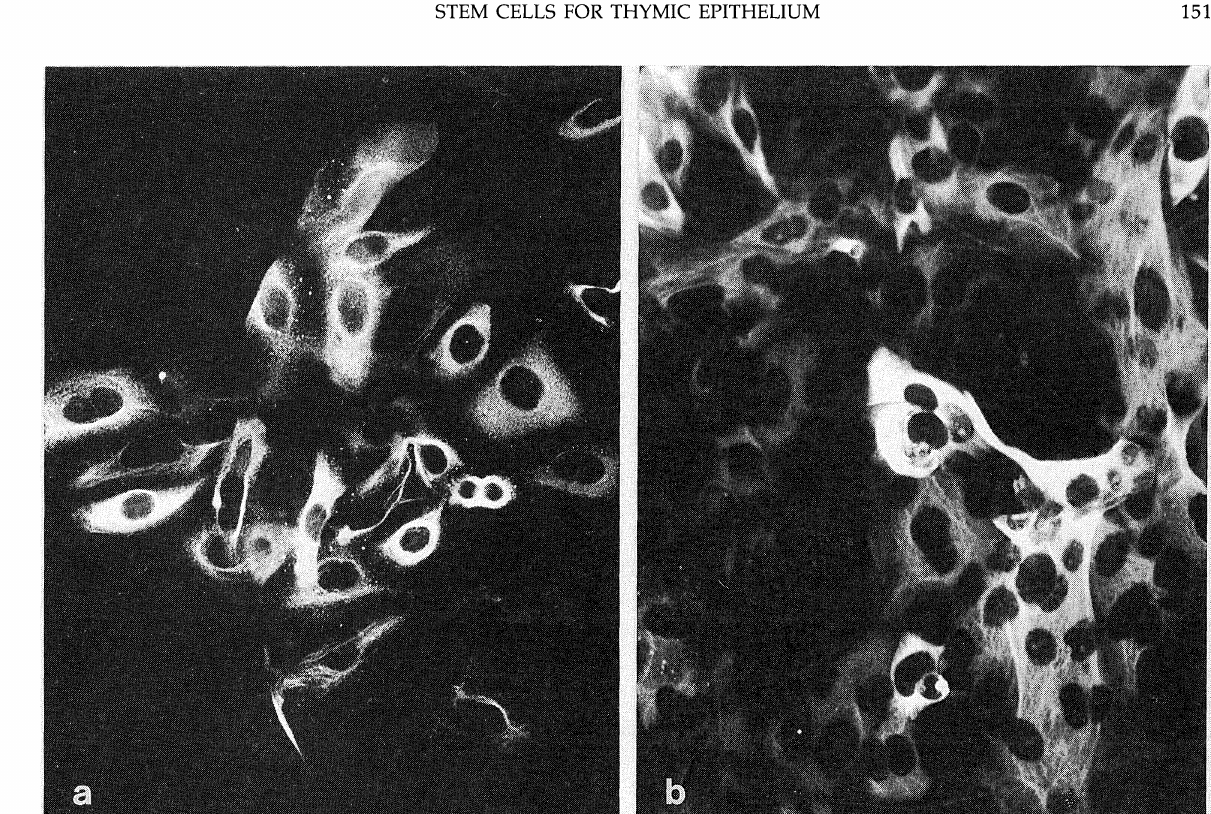
FIGURE 2. Fluorescence photomicrographs of cultured murine thymic epithelial cells. (a) Cells were labeled with ER-TR4 antibody against cortical epithelial cells. (b) Cells were labeled with ER-TR5 antibody against medullary epithelial cells. RaRA-FITC was used as second layer for detection of both antibodies. The cells were derived from 15-day-old fetuses, and were grown for 12 days in serum-free medium (x